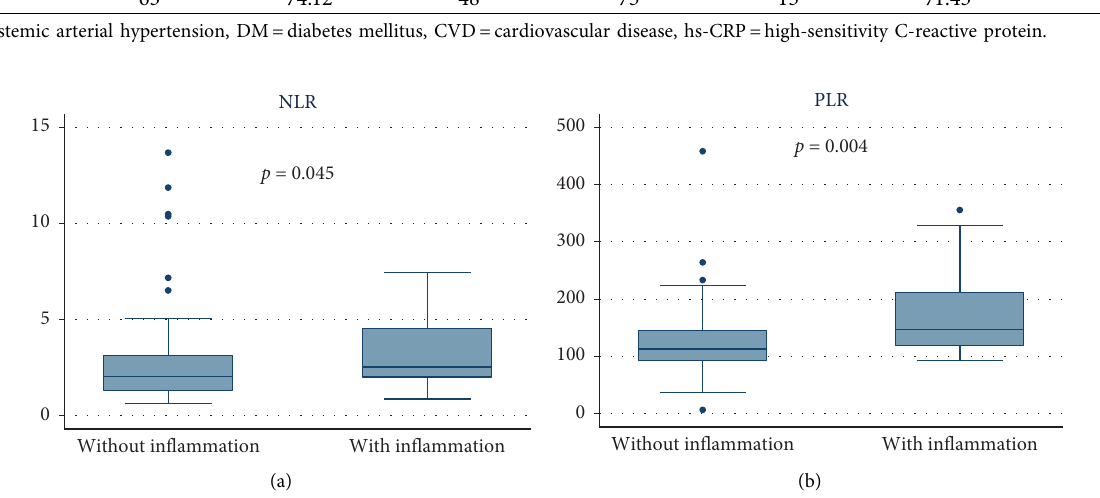
Figure 1: Comparison between groups with and without inflammation based on NLR and PLR in nondialysis patients with chronic kidney disease, using the Mann–Whitney U test; NLR: neutrophil-to-lymphocyte ratio; PLR: platelet-to-lymphocyte ratio. Table 2: Characteristics and laboratory findings according to hs-CRP groups in nondialysis patients at the Kidney Disease